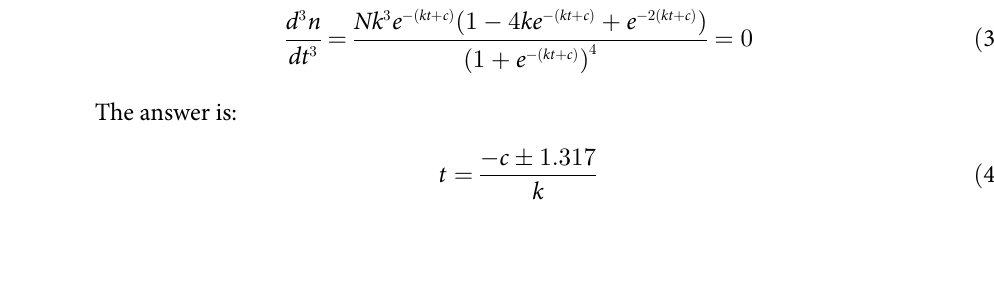
Fig 1. Geographical distribution and incidence distribution in Hunan Province, Jilin Province, Shenzhen City, Xiamen City, Chuxiong Prefecture, Yunxiao County, and Longde County. Fig 1A shows the locations and reported cases of in Hunan Province, Jilin Province, Shenzhen City, Xiamen City, Chuxiong Prefecture Yunxiao County, and Longde County in the map of mainland China. The dark grey regions include provinces with severe HFMD outbreaks every year. China can be roughly divided into two parts according to its humidity and temperature: the drier and colder part in the northwest and the more humid and warmer part in the southeast (Fig 1B). Five of the seven regions belong to the subtropical zone and two belongs to the mid-temperate zone. The southeast part includes tropical, subtropical and warm temperate zones; the northwest part includes middle temperate zone, the plateau zone and the middle and warm mixture zone. Fig 1C shows the time series of incidence in Hunan Province, Jilin Province, Shenzhen City, Xiamen City, Chuxiong Prefecture, Yunxiao County, and Longde County. The map depicted in this figure was taken from Wikimedia Commons https://commons.wikimedia.org/wiki/Atlas_of_the_People%27s_Republic_of_China#/media/